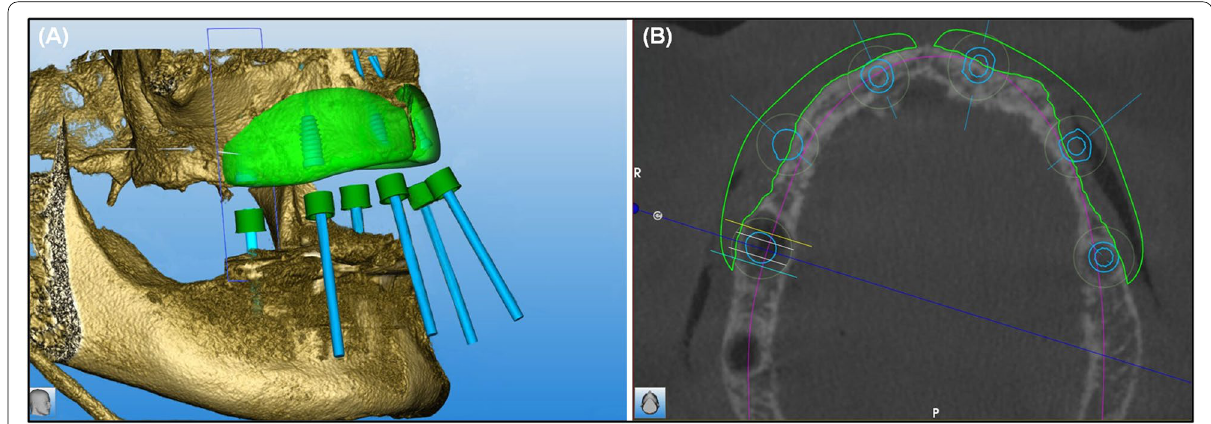
Fig. 1 Digital planning based on a 3D X‑ray image (DICOM file) for the design of the planned allogeneic bone blocks, including optimised subsequent implant